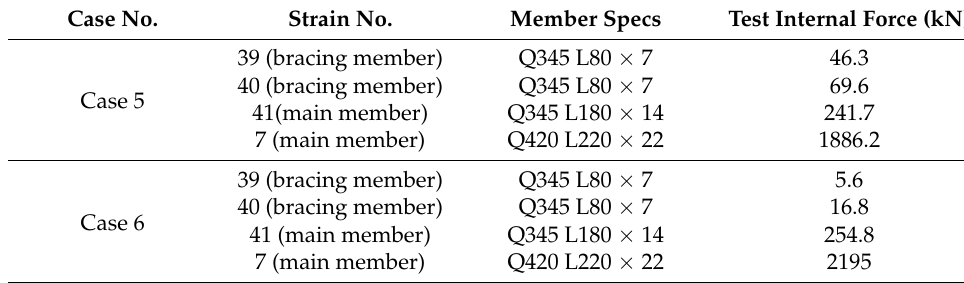
Table 3. Test results of tower legs.